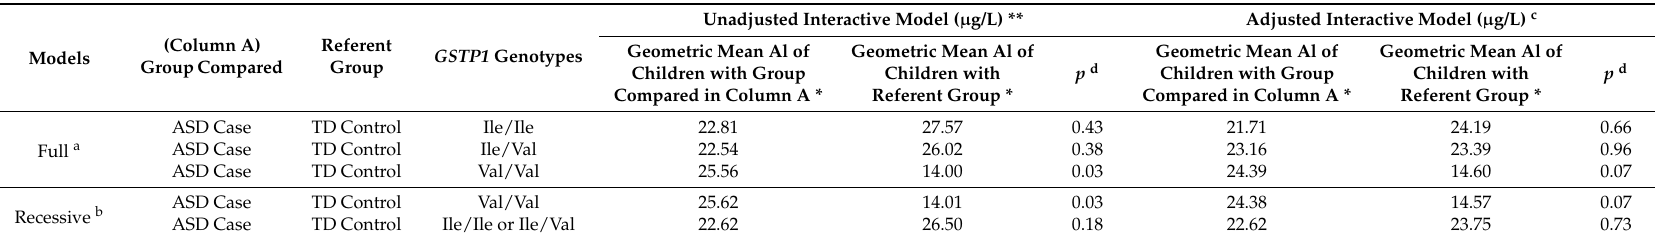
Table 5. Unadjusted and adjusted geometric mean blood aluminum concentrations by ASD status (ASD and TD control) based on General Linear Models (GLM) that includes interaction between GSTP1 genotypes and ASD case status (ASD and TD control) (106 matched pairs).